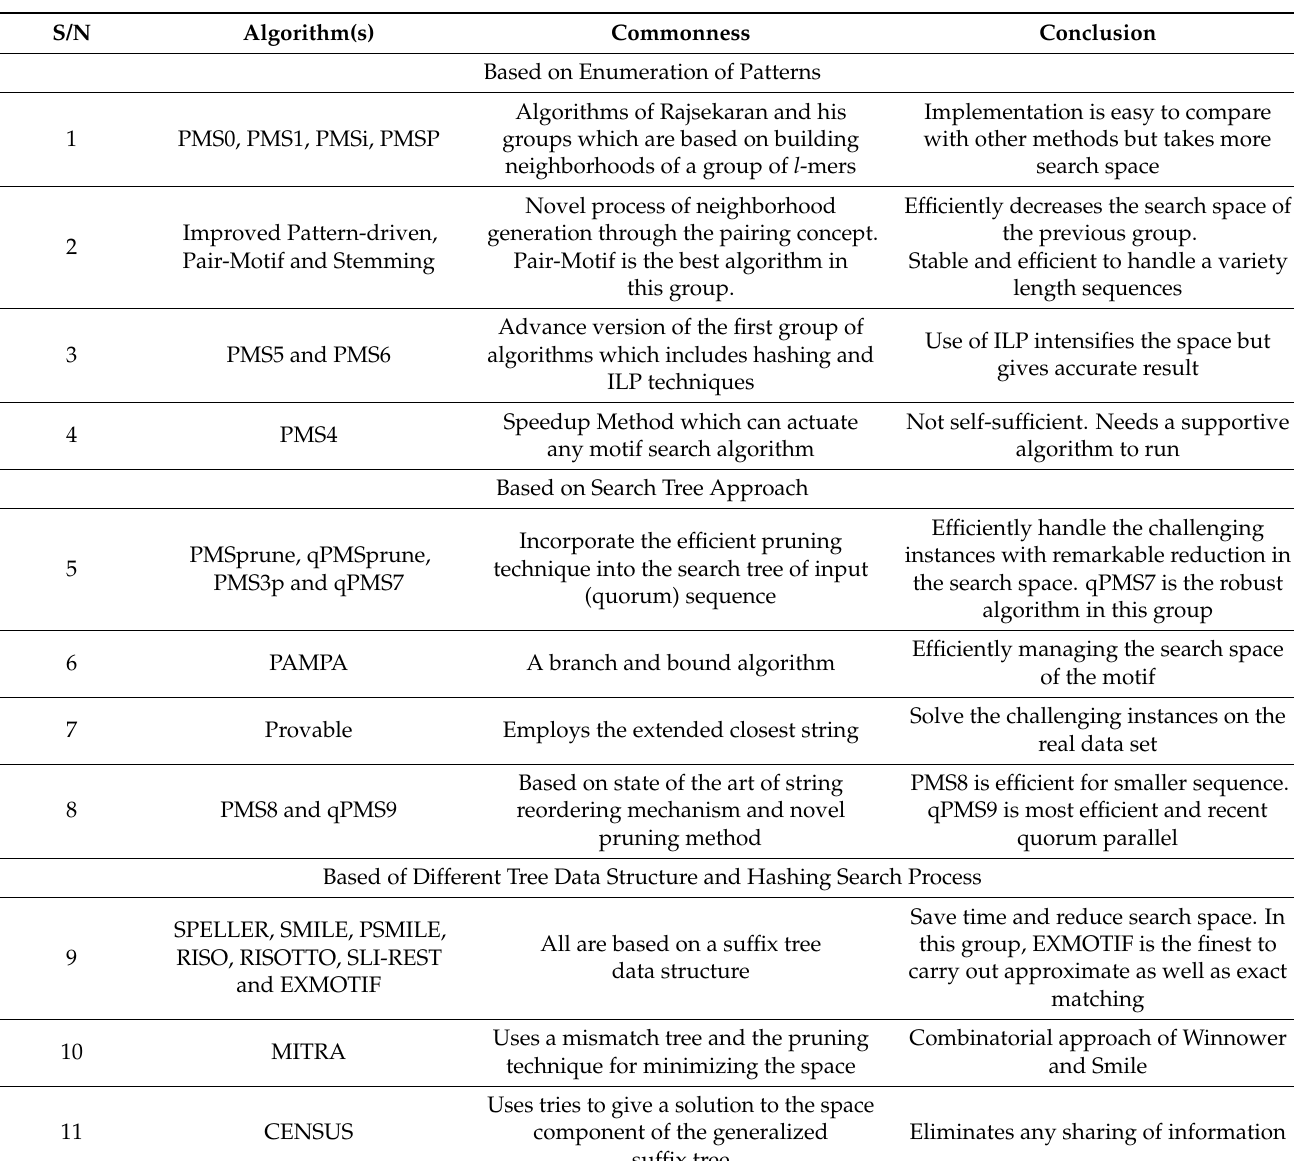
Table 4. Summary of Motif Discovery Algorithms based on Exact